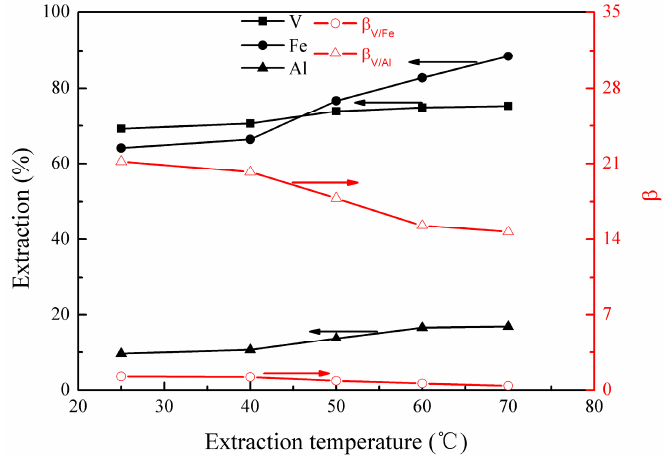
Figure 2. Effect of extraction temperature on the extraction percentages of V (IV), Fe, and Al, as well as on the separation factors β V/Fe and β V/Al .